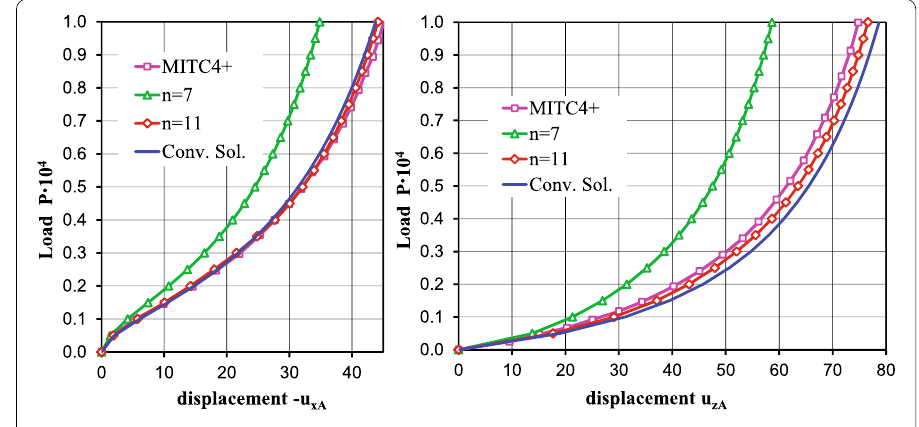
Fig. 25 Hook problem: P − u xA and P − u zA for the regular 4 × 8 × 12 mesh